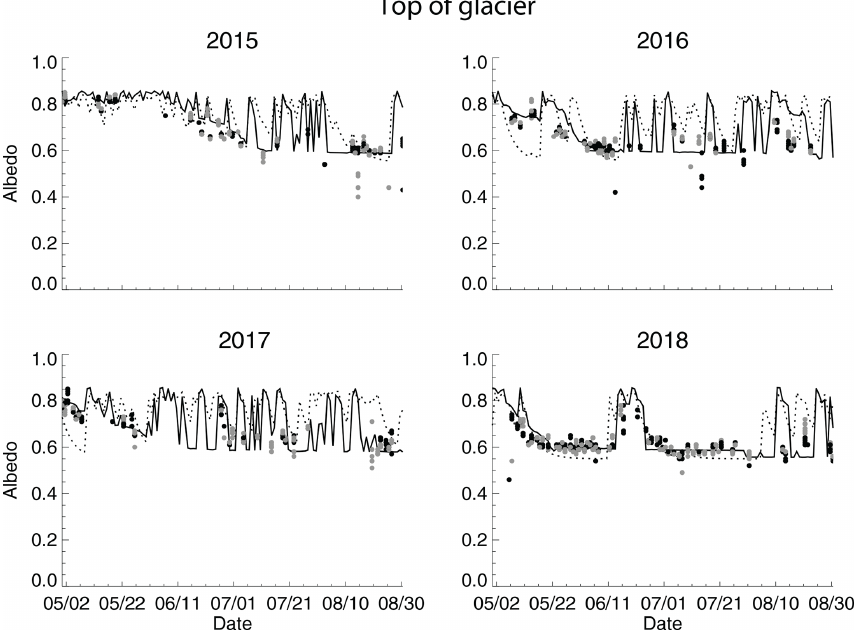
Figure 14. Observed and modeled albedo at the top of Hardangerjøkulen. Dots represent observed albedo from the MODIS satellite (gray – Terra; black – Aqua). The solid line is albedo from the Crocus snow model, and the dashed line is albedo from the Noah-MP snow model.